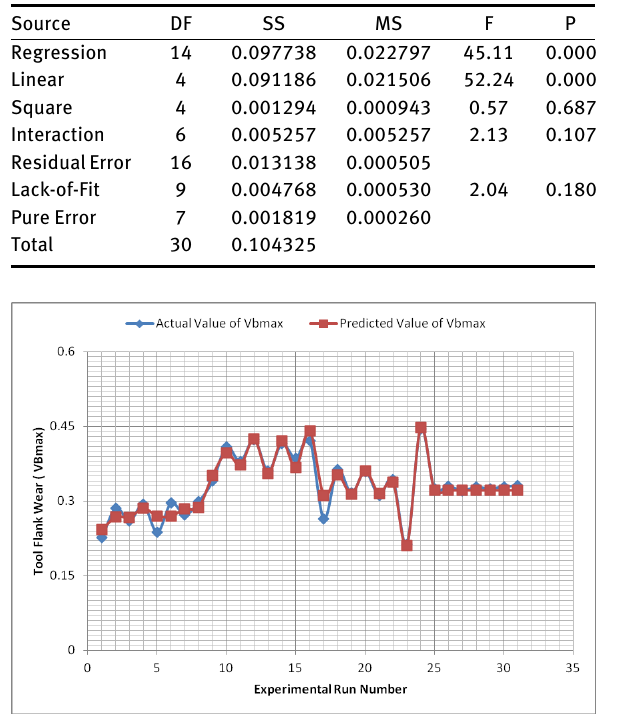
Figure 1: Comparison between Actual Value and Predicted Value of the Tool Wear.